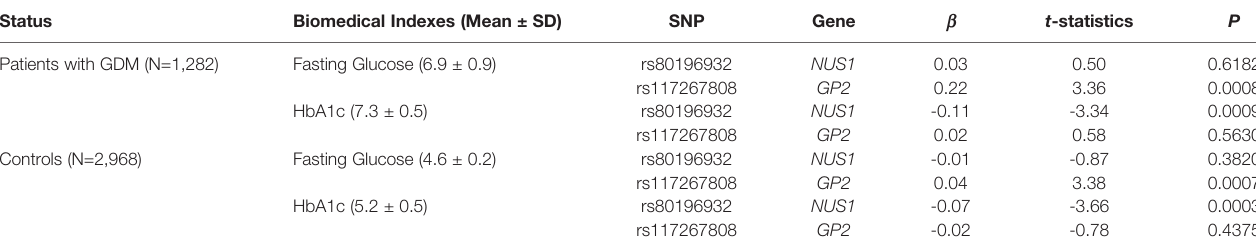
TABLE 3 | Associations between signi fi cant SNPs and GDM related biomedical indexes strati fi ed by disease status. Biomedical Indexes (Mean ± SD) Patients with GDM (N=1,282)